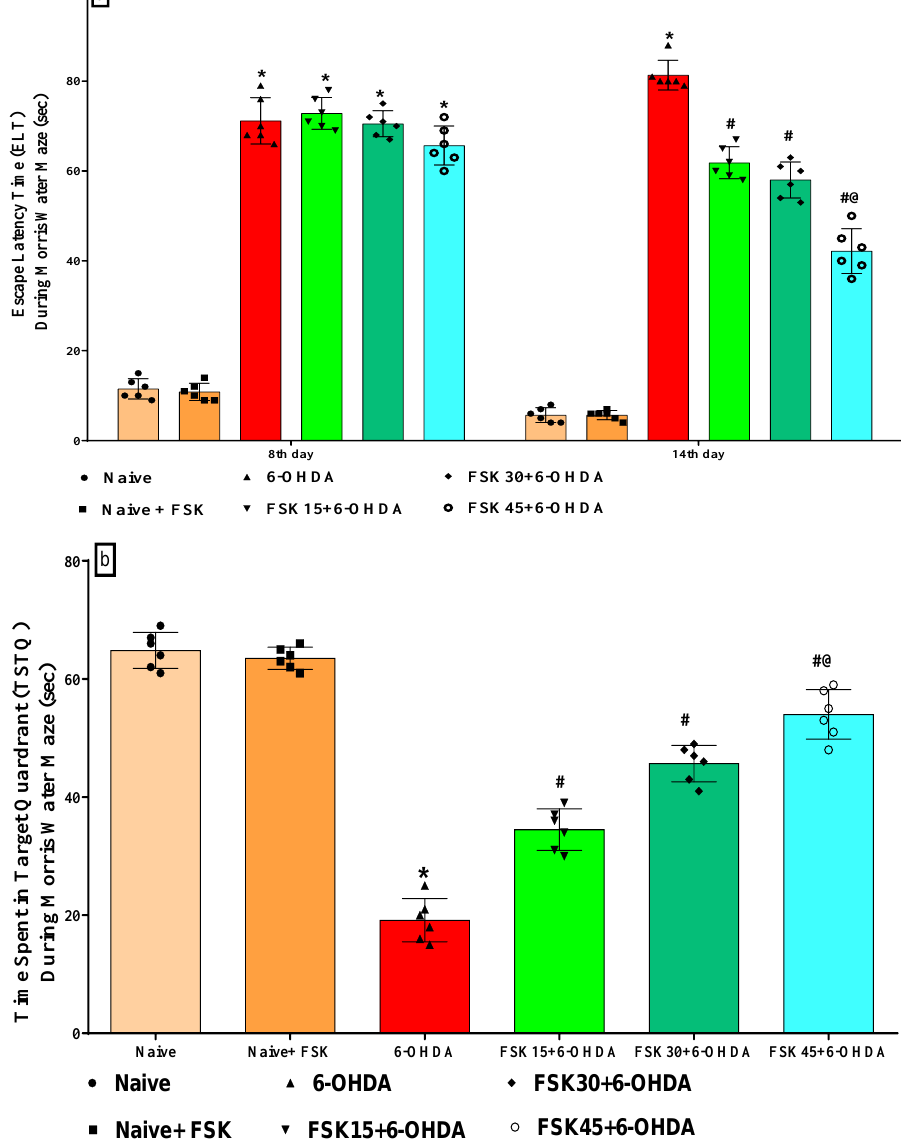
Figure 1. ( a ) FSK improved escape latency time using the Morris water maze in the experimental model of PD. Data provided as mean ± SD (n = 6) followed by ANOVA (two-way) with post-hoc Bonferroni test . * 6-OHDA ( p < 0.01) compared with naive and naive + FSK ; #FSK15, FSK30, FSK45 (p < 0.01) compared with 6- OHDA ; #@ FSK45 (p < 0.01) compared with FSK30, FSK15 . ( b ) FSK improved TSTQ using the Morris water maze in the experimental model of PD. Data provided as mean ± SD (n = 6 ) followed by ANOVA (one-way) with post-hoc Tukey’s test. * 6-OHDA ( p < 0.01) compared with naive and naive + FSK ; #FSK15, FSK30, FSK45 (p < 0.01 ) compared with 6-OHDA ; #@ FSK45 (p < 0.01 ) compared with FSK30, FSK15